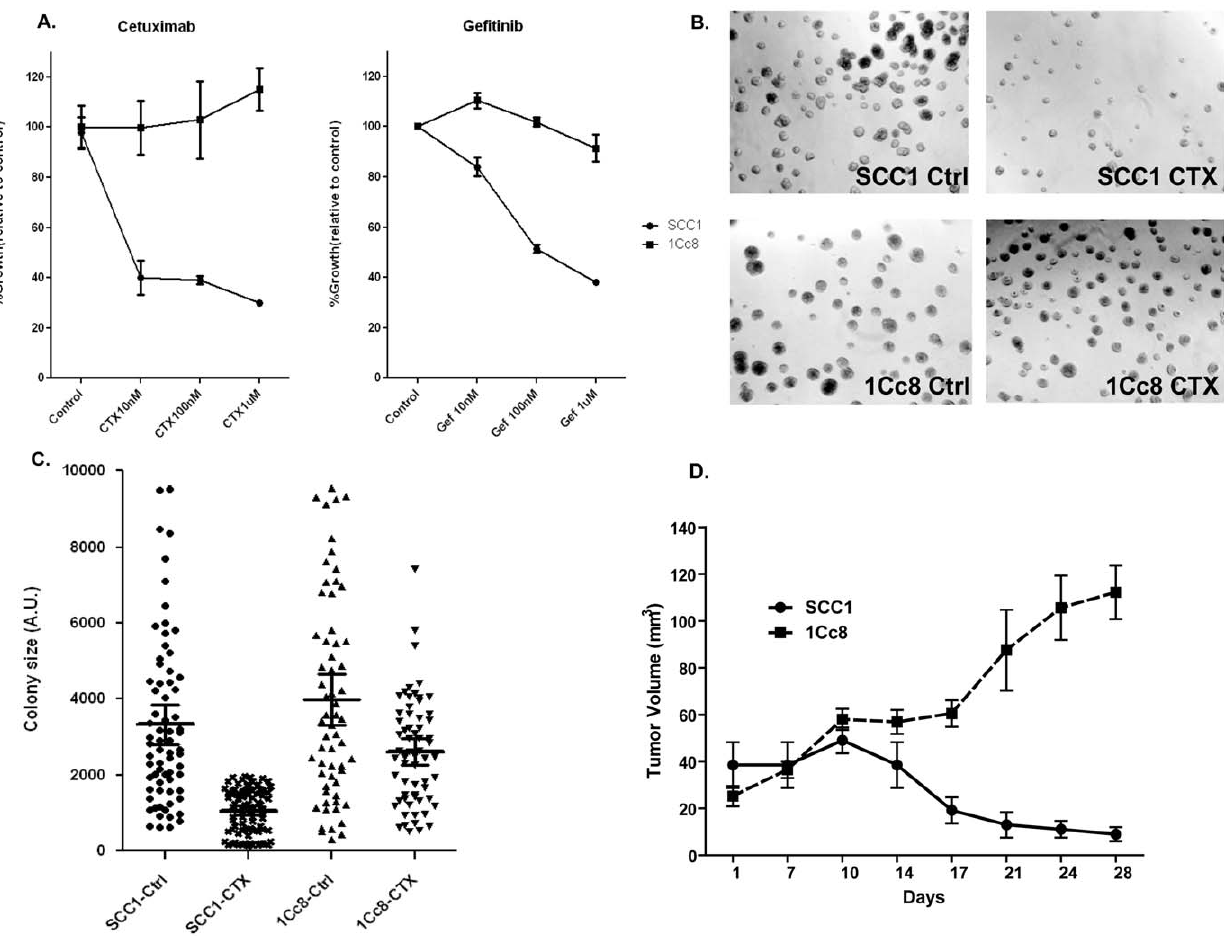
Figure 1. Determination of cetuximab sensitivity. Cetuximab response determination of SCC1 and 1Cc8 HNSCC cell lines by; A) MTS assay, B) colony formation assay, C) graphical presentation of the colony formation assay, A. U.- Arbitrary Unit, and D) growth inhibition in mouse xenografts. CTX-cetuximab. Ctrl-control.